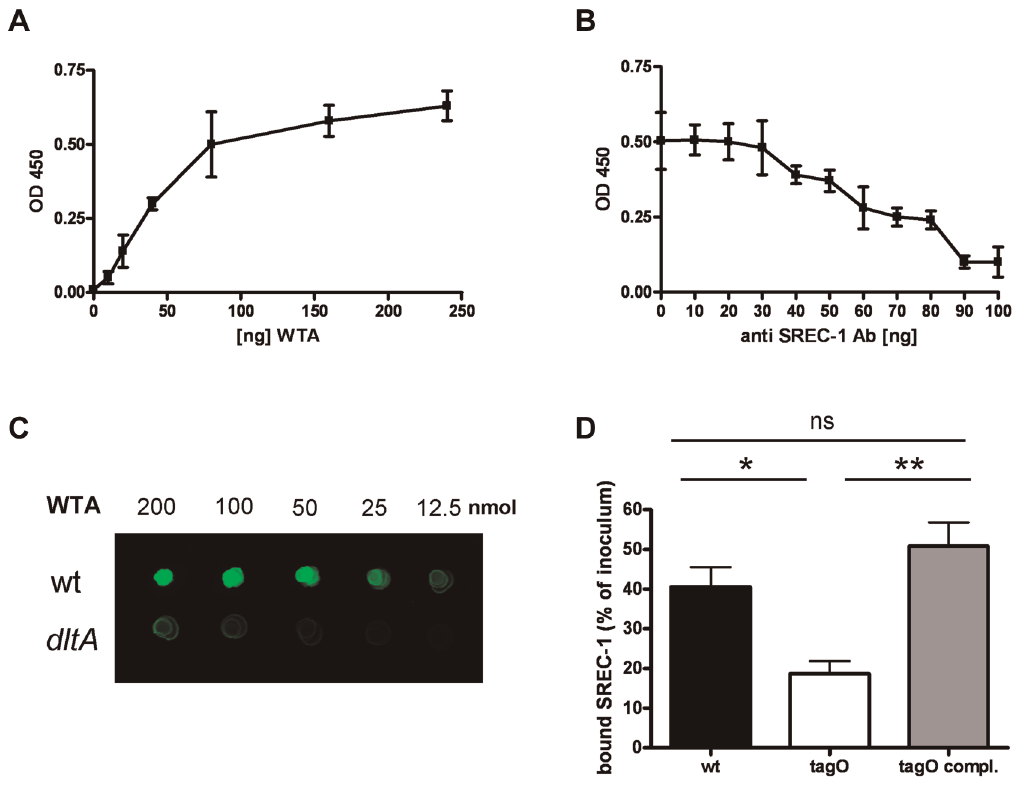
Figure 2. Direct interaction of SREC-I and WTA. Binding of SREC-I to WTA in a microtiter plate-based assay with immobilized WTA at different concentrations. Interaction of a biotin-labeled SREC-I Fc-chimera with WTA was detected with a Streptavidin-HRP conjugate. The data represent means 6 SD of 3 independent experiments. (A). Incubation with increasing concentrations of an SREC-I function blocking antibody at a concentration of 80 m g/ml immobilized WTA. The data represent means 6 SD of 3 independent experiments. (B).Interaction of WTA spotted in increasing concentrations on a nitrocellulose membrane with a SREC-I Fc-chimera (500 ng/ml)(C). Bound SREC-I Fc-chimera was detected with a secondary antibody coupled to an 800 nm emitting infrared dye on a LI-COR Odyssey infrared imaging system. A representative experiment is shown here (C). Binding of SREC-I to whole bacterial cells, measured with a FITC-labeled SREC-I Fc-chimera. Wild-type S. aureus , the isogenic tagO mutant and the complemented mutant ( tagO -pRB tagO ) were incubated with 50 m g/ml FITC-labeled SREC-I. The bound fluorescence was calculated by subtracting the unbound fluorescence from the total fluorescence of the FITC-labeled SREC-I solution. The mean and SD of 3 independent experiments are shown. Statistical analysis was performed by Student’s t-test. Significant differences vs. wild-type strains are indicated by one ( P , 0.05), two ( P , 0.01), or three ( P , 0.001) asterisks ( * ) (D).